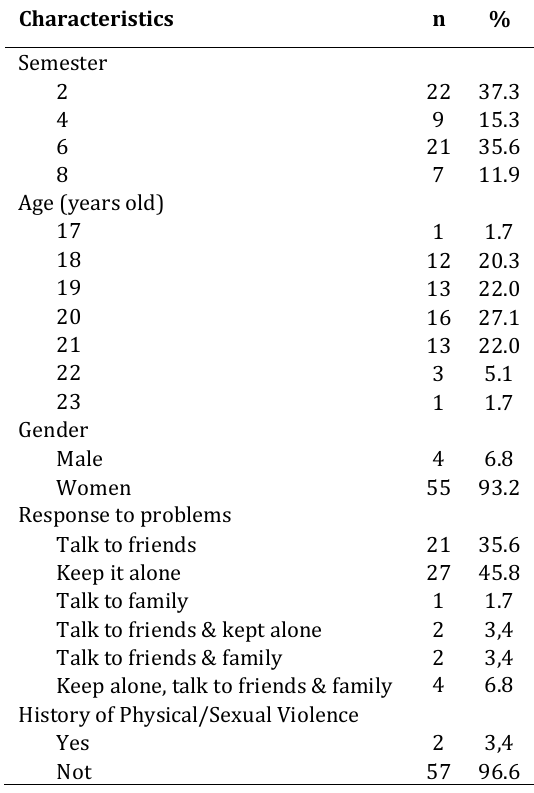
Table 1. Respondents’ Characteristics (N = 59)